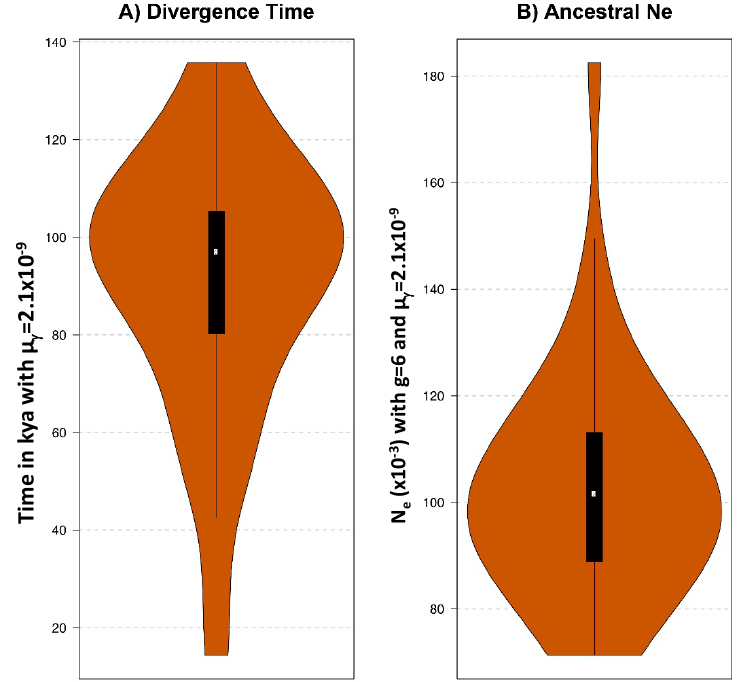
Figure 6. Inference of the divergence time of the American and European bison and of the size of their ancestral population. Characterization of the divergence between the B. bonasus and B. bison lineages under an isolation model, which assumes a clean split, using CoalHMM [40]. ( A ) Violin plot showing the distribution of the estimates of divergence times over 37 non-overlapping and autosomal segments from the alignments of B. bonasus and B. bison genome assemblies [8]. Time scale was translated into years before present assuming µ y = 2.1 × 10 − 9 [43]. ( B ) Violin plot showing the distribution of the estimates of the ancestral effective population size, Ne, scaled by assuming in addition a generation time g of 6 years